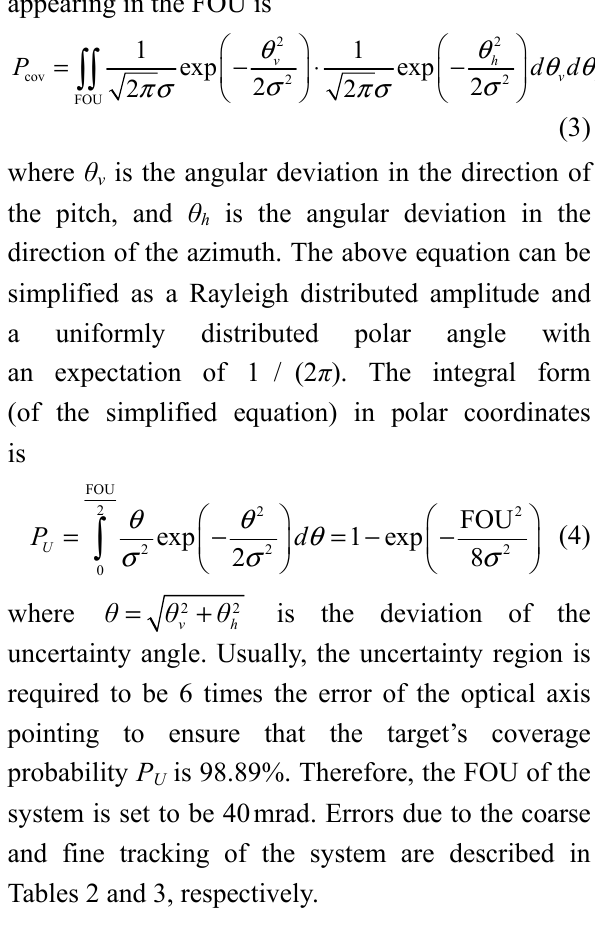
Table 2 Error Analysis of coarse tracking.